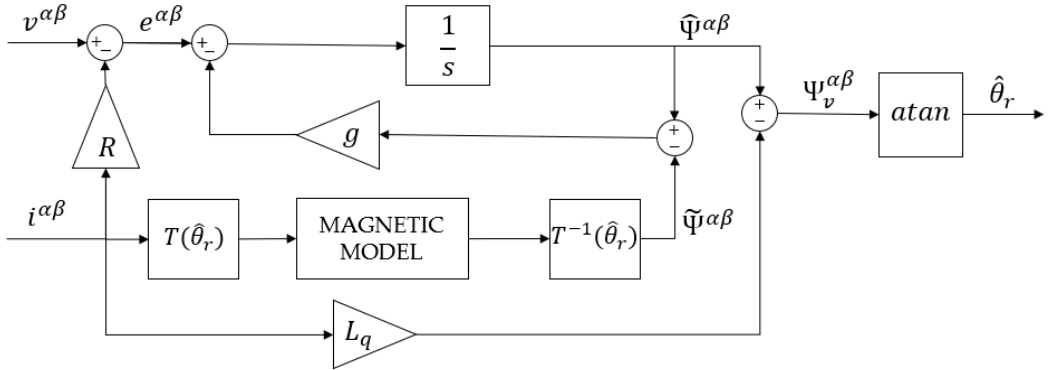
Figure 6. Reduced order observer with rotor angle